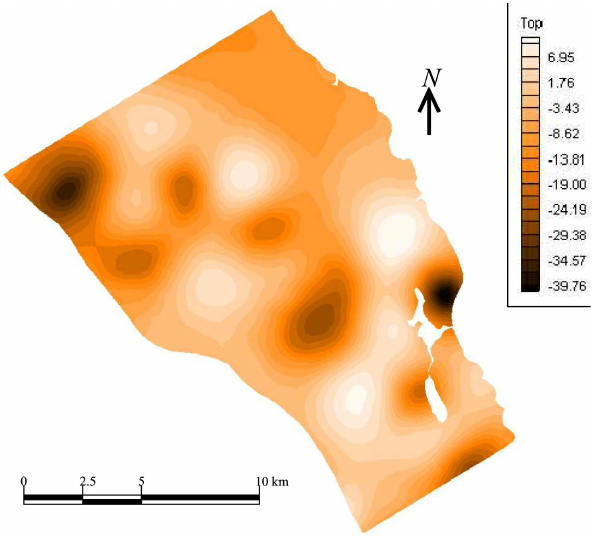
Figure 12: interpolation of top of well screen Fig. 12. Interpolation of top of well screen.